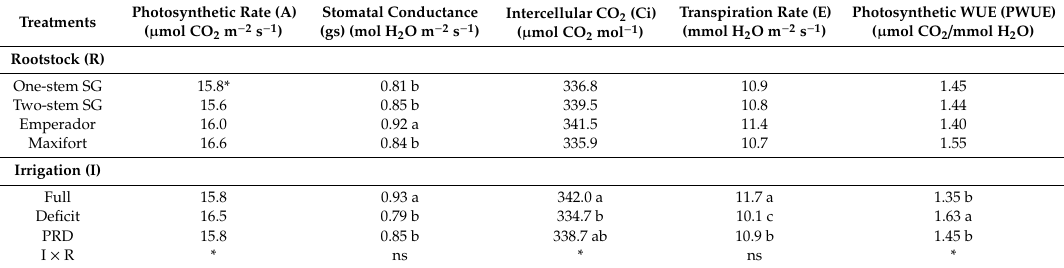
Table 3. Leaf gas-exchange parameters and photosynthetic water-use e ffi ciency of grafted tomatoes grown with one and two stems under three irrigation techniques in the second year of the experiment. Treatments